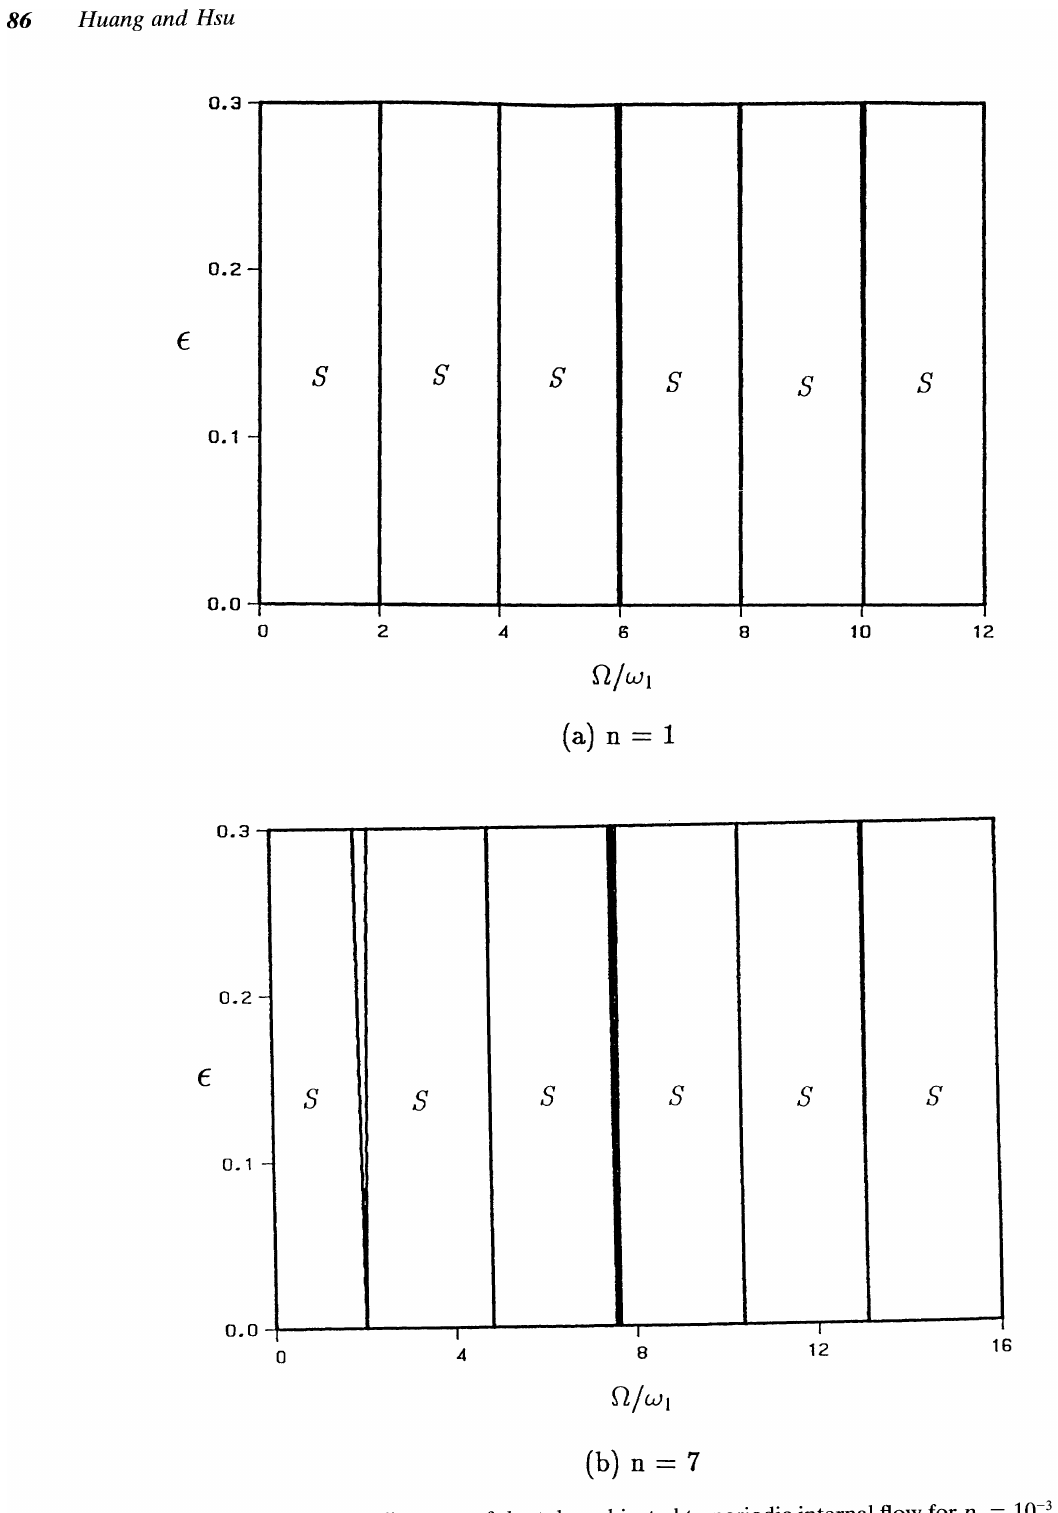
FIGURE 5 Stability diagrams of the tube subjected to periodic internal flow for po = 10- 3 , m = 1, and (a) n = 1 and (b) n =